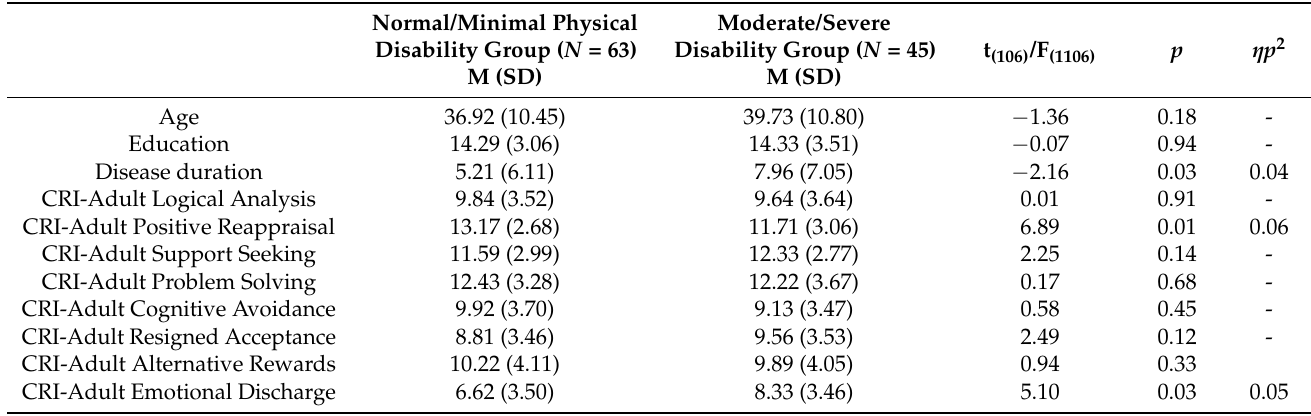
Table 5. Differences in demographic data, disease duration, and coping strategies between the “normal/minimal physical disability” and the “moderate/severe physical disability”